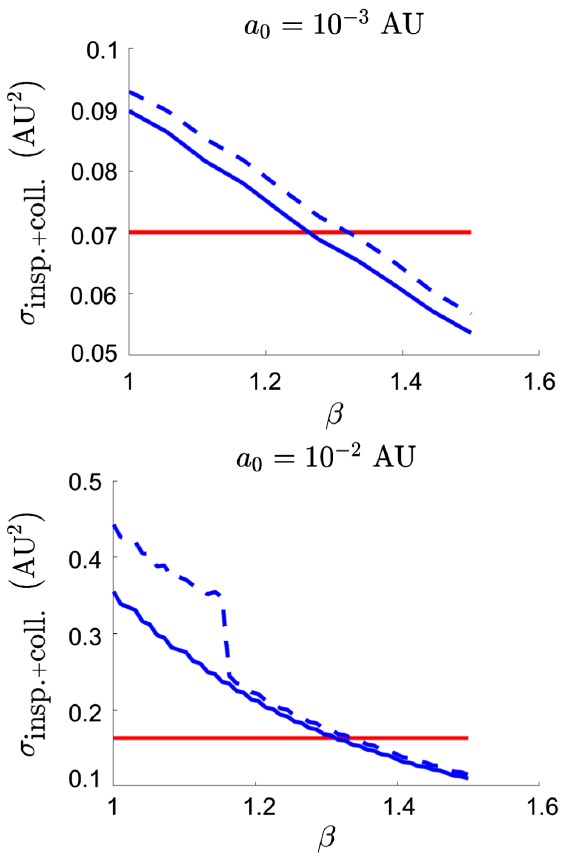
FIG. 6. Inspiral or collision cross section for the case described in the text, for different values of β [defined in Eq. (10)]. The red line is the result of the simulations of Samsing et al. [28]; the blue line shows our result, using the tidal model of Eq. (66), while the dashed blue line shows the cross section if the model in Eq. (67) is employed. There is some noise due to numerical integration. Top panel: a 0 ¼ 10 − 3 AU. Bottom panel: a 0 ¼ 10 − 2 AU. In both cases, v 0 ¼ 10 km s − 1 , and y is chosen to be very